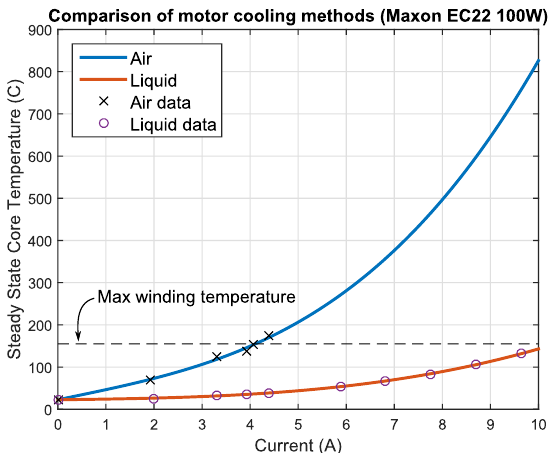
Figure 13. This figure compares the performance of air versus liquid cooling as applied to the COTS Maxon EC22 100-W motor. Here, the performance metric is steady-state continuous current. Maximum current is defined to be the current that produces a steady-state core temperature of 155 ◦ C. By this metric, liquid cooling outperforms air cooling by a factor of 2.58 (4.07 A versus 10.5 A) for the Maxon EC22 100-W motor. This factor is motor dependent, but is accurately approximated (in this case to within 9%) by the motor’s thermal ratio (2.83 for the Maxon EC22 100 W; refer back to Section